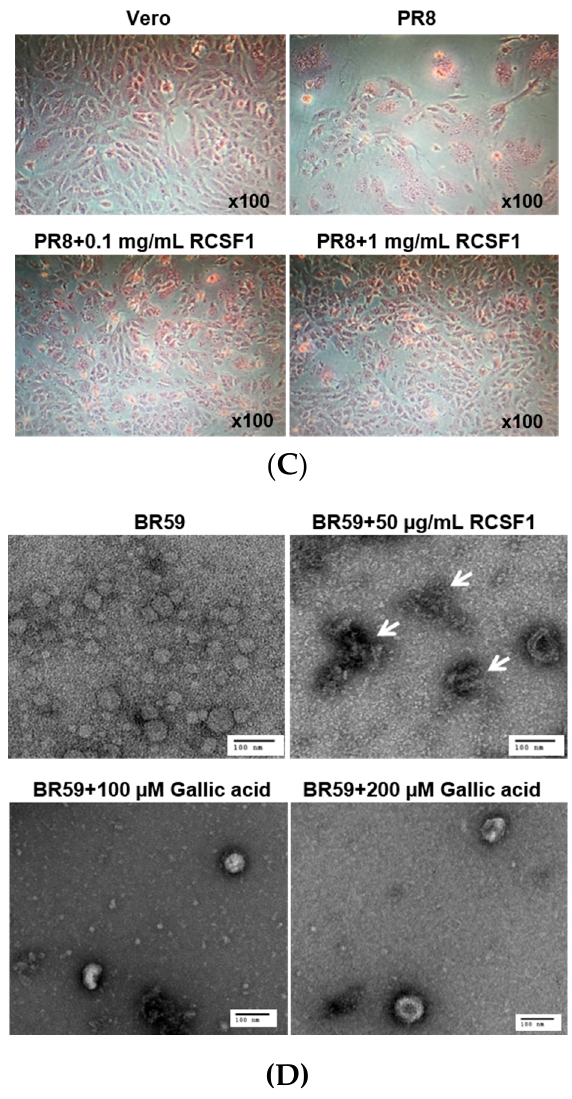
Figure 2. Inhibitory effects of RCSF1 or GA at the early stage of viral infection. ( A ) Hemagglutination inhibition assay. Diluted RCSF1 or NA-treated RCSF1 were incubated with virus and 0.5% chicken red blood cells for 1 h; ( B ) Differential scanning fluorometry profile of influenza virus HA in the absence and presence of RCSF1; ( C ) Effect of RCSF1 on syncytium formation in PR8-infected Vero cells; ( D ) Effects of RCSF1 or GA on virus particles based on TEM images. White arrows indicate disrupted virus particles. Scale bars, 100 nm.